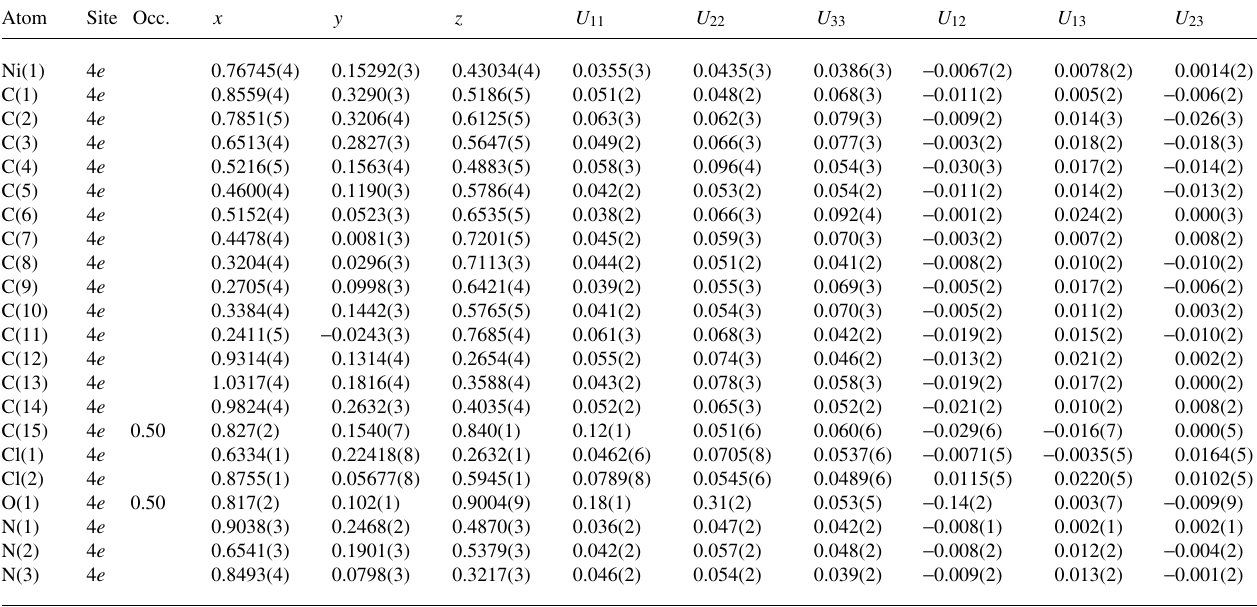
Table 3. Atomic coordinates and displacement parameters (in Å 2 )